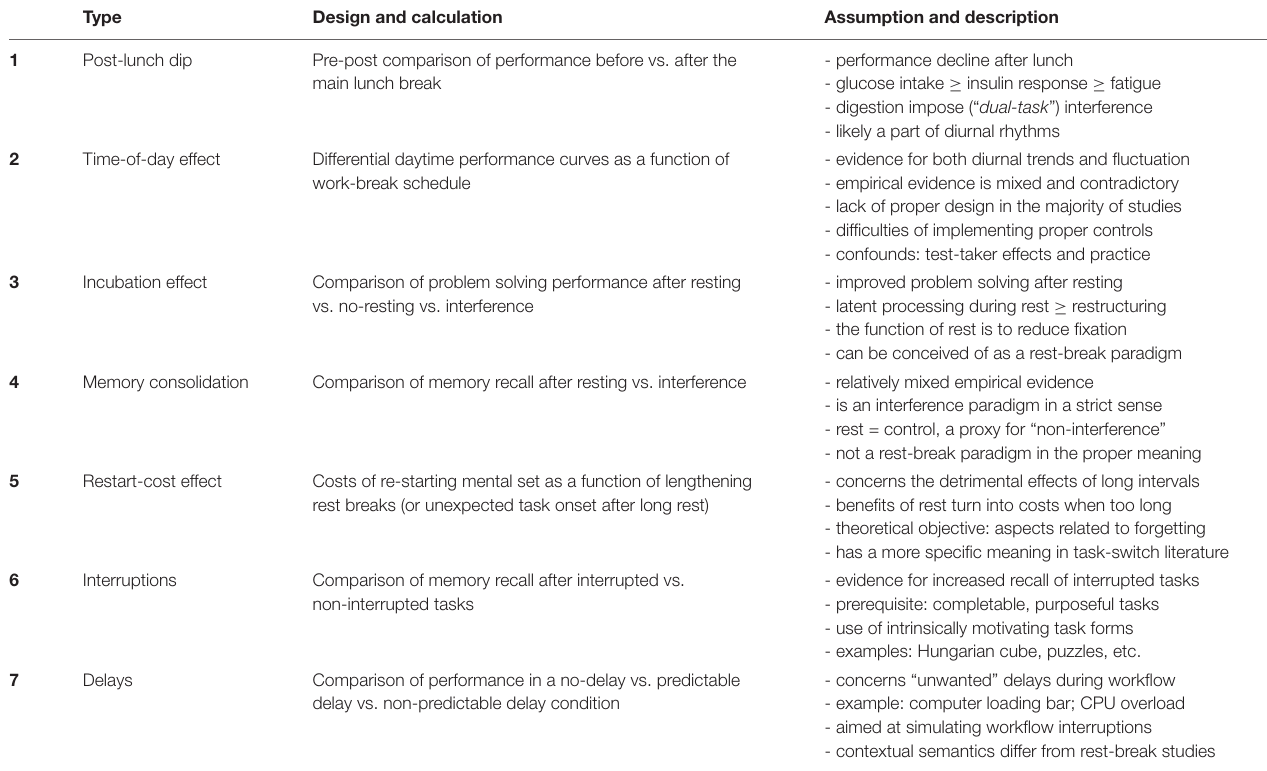
TABLE 1 | Overview and description of paradigms and phenomena closely related to rest-break